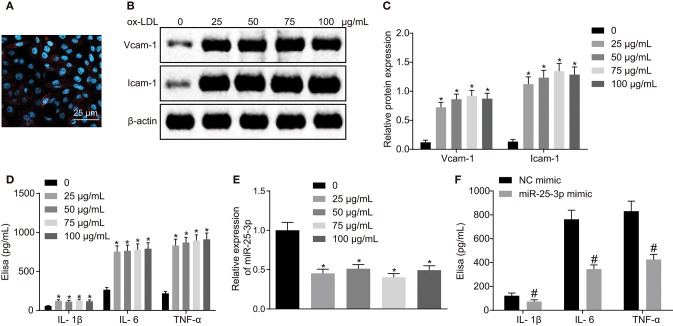
Lowly expressed miR-25-3p is observed in the CVEC model treated with ox-LDL. (A) CD31 immunofluorescence staining in CVECs (Scale bar = 25 μm). (B,C) Protein levels and bands of Vcam-1 and Icam-1 in CVECs treated with ox-LDL, as determined by Western blot analysis. (D) Levels of inflammation markers (IL-1β, IL-6, and TNF-α) in CVECs treated with ox-LDL, as detected by ELISA. (E) MiR-25-3p expression in CVECs treated with ox-LDL, as determined by RT-qPCR. (F) Levels of IL-1β, IL-6, and TNF-α in CVECs treated with miR-25-3p, as measured by ELISA. *p < 0.05 vs. the 0 group (CVECs without treatment of ox-LDL). #p < 0.05 vs. the NC mimic group (CVECs treated with NC mimic). The measurement data are expressed as mean ± standard deviation, and data between two groups were analyzed using an independent sample t-test while comparisons among multiple groups were conducted using one-way analysis of variance. The experiment was repeated three times independently.